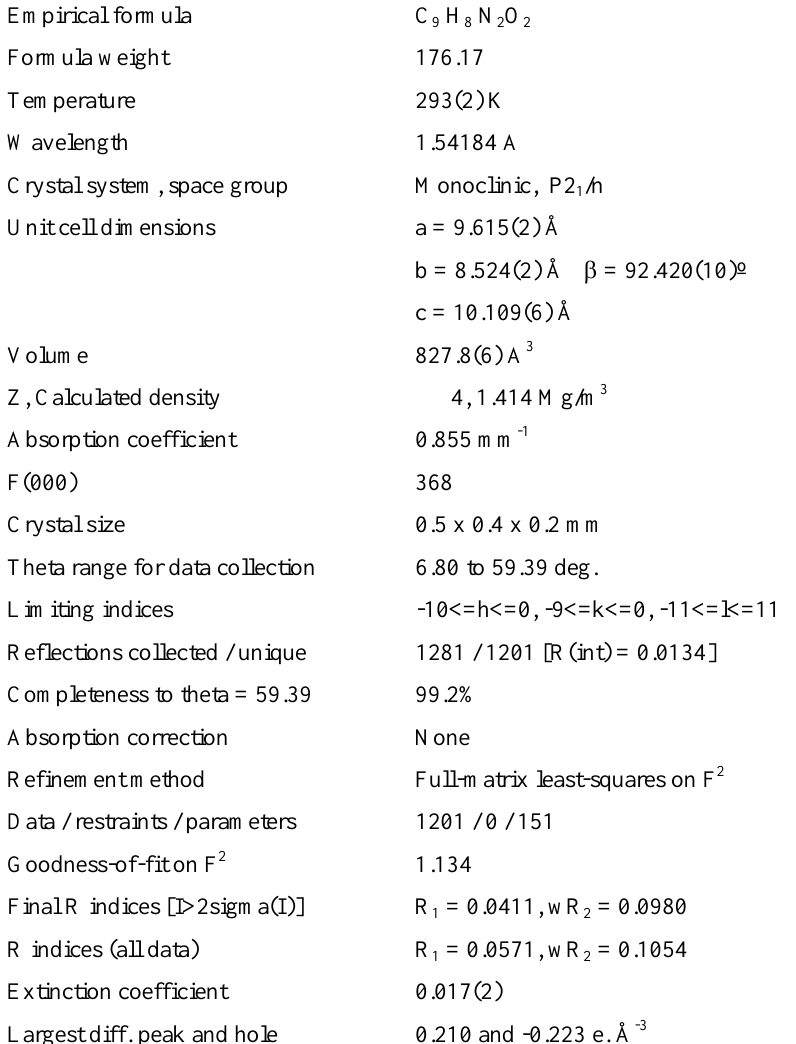
Table 7. Crystal data and structure refinement for compound 5b